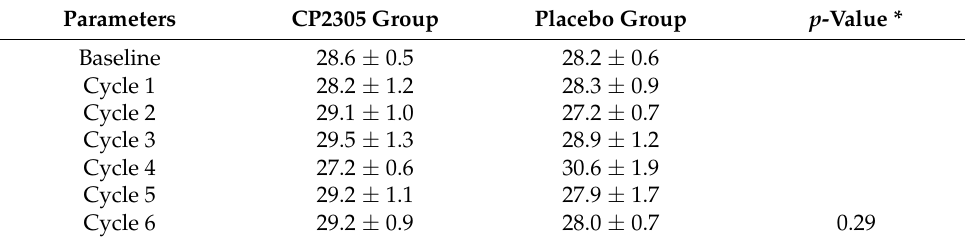
Table 4. Transitions in menstrual cycle